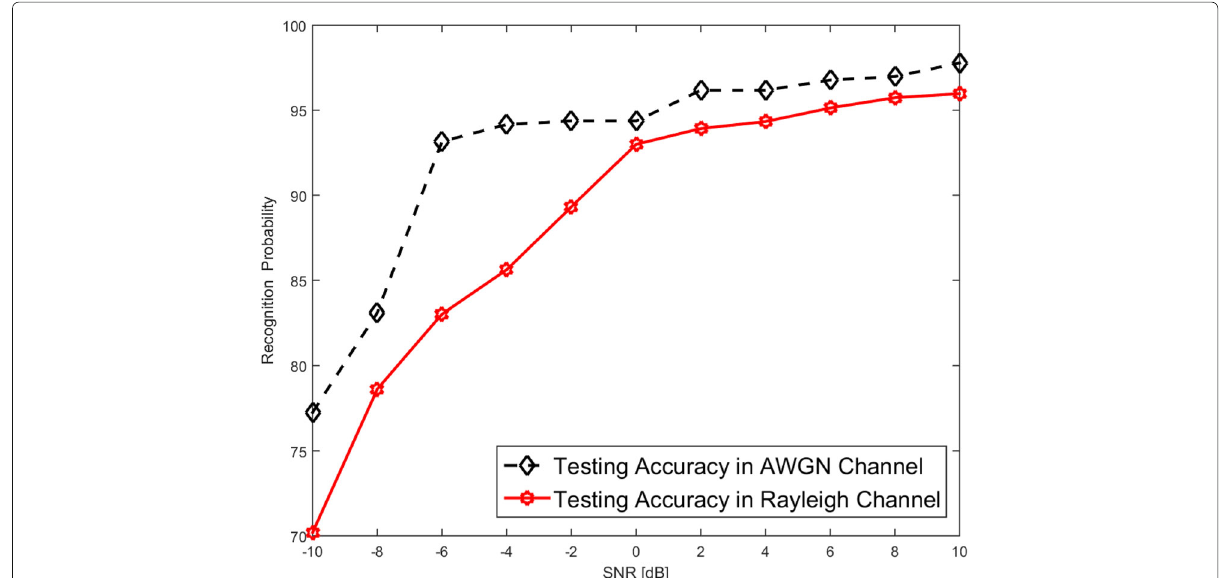
Fig. 2 φ 1 in the AWGN and Rayleigh fading